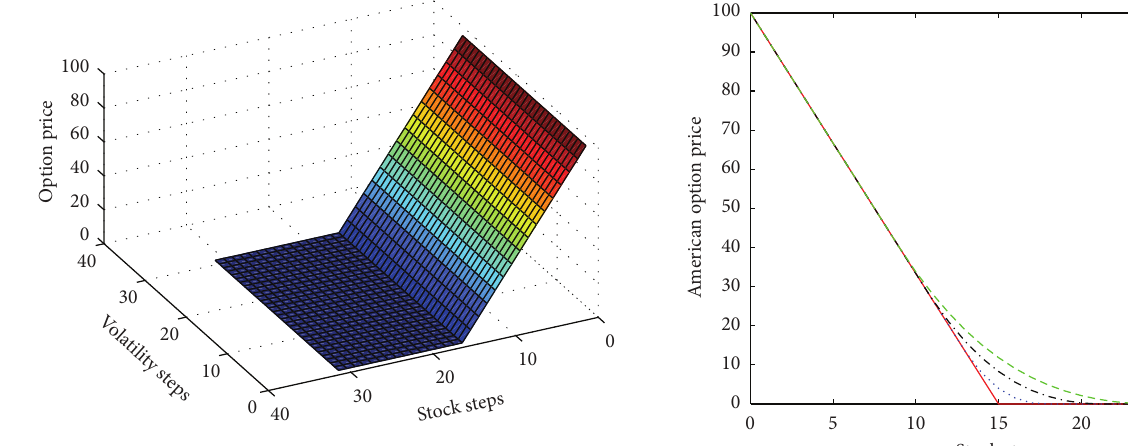
Figure 1: The payoff as a function of stock price (stock price = stock step ∗ 20/3; volatility = volatility step ∗ 1/30).